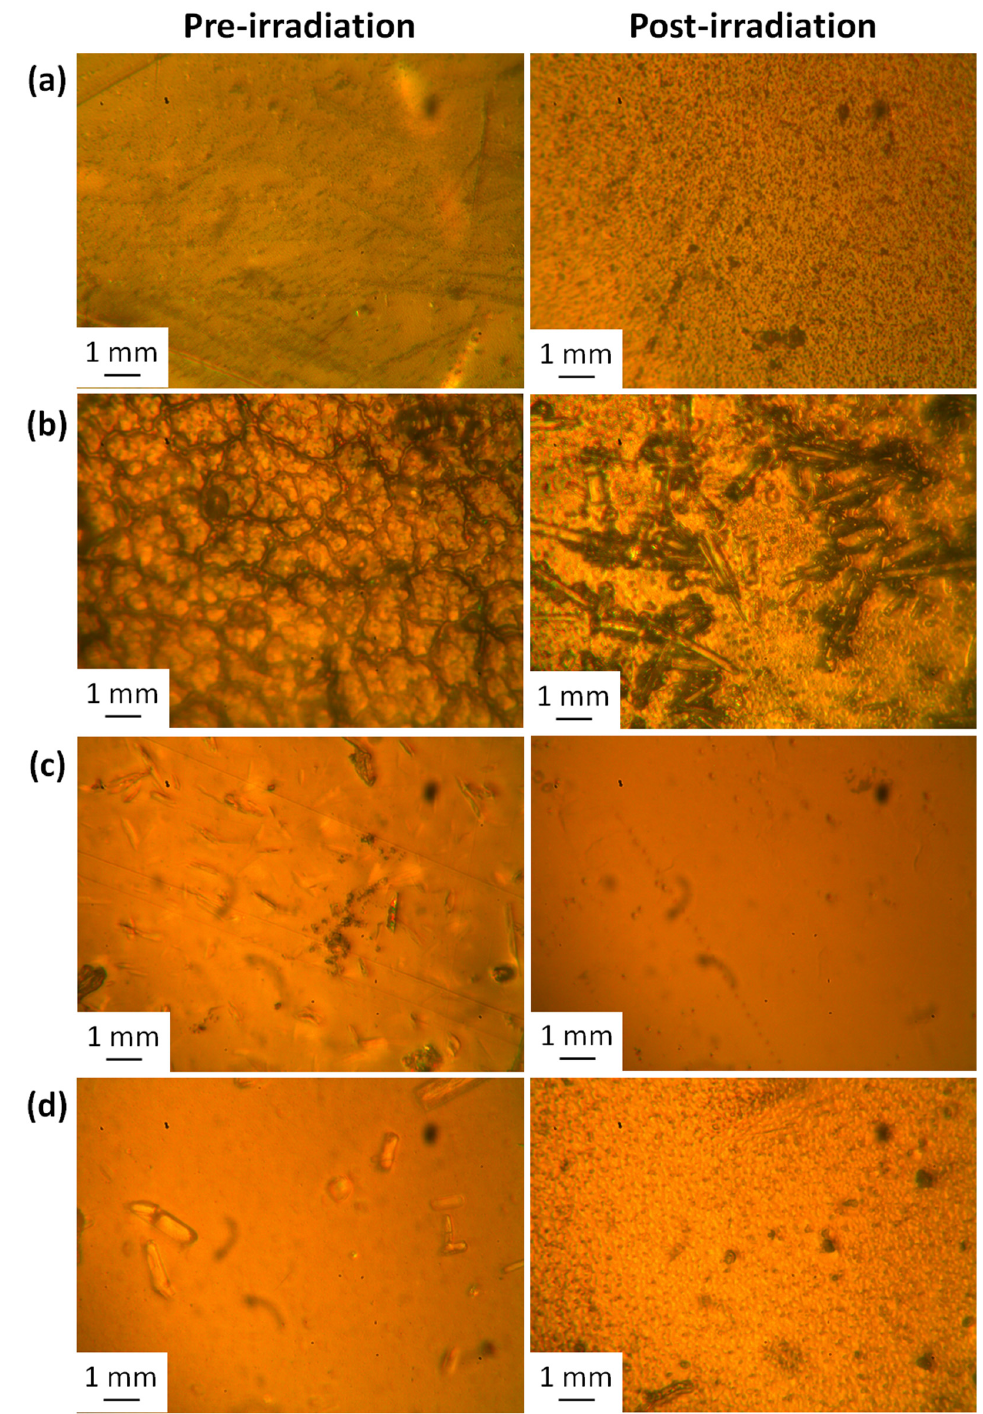
Figure 5. Microscope images of: ( a ) PVC blank ( b ) PVC + 1 , ( c ) PVC + 2 , and ( d ) PVC + 3 blends both before and after irradiation.